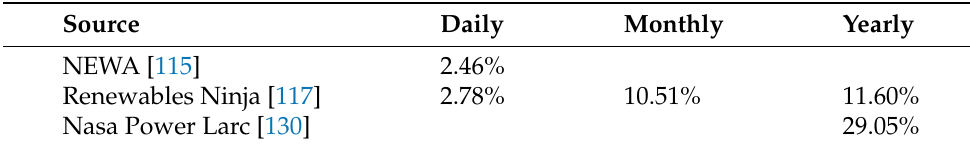
Table 7. Deviation compared to the FiNO 3